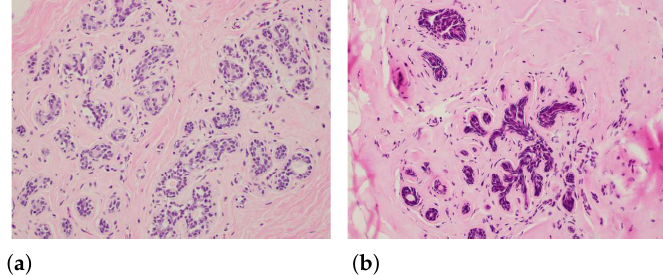
Figure 10. 20 X magnification of histology slide showing intact glandular lobule ( a ) and evidence of thermal damage in glandular lobule ( b